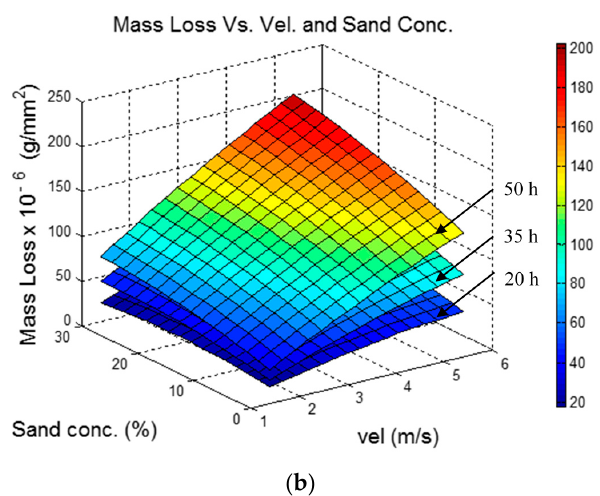
Figure 7. Mass loss versus velocity and sand concentration for constant times ( t = 20 h, 35 h, and 50 h); ( a ) First-order polynomial; ( b ) Second-order polynomial.